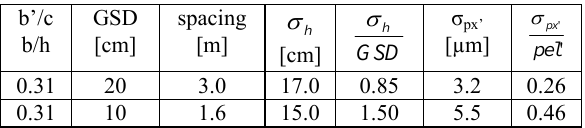
Table 2. Results of automatic DTM derivation in open